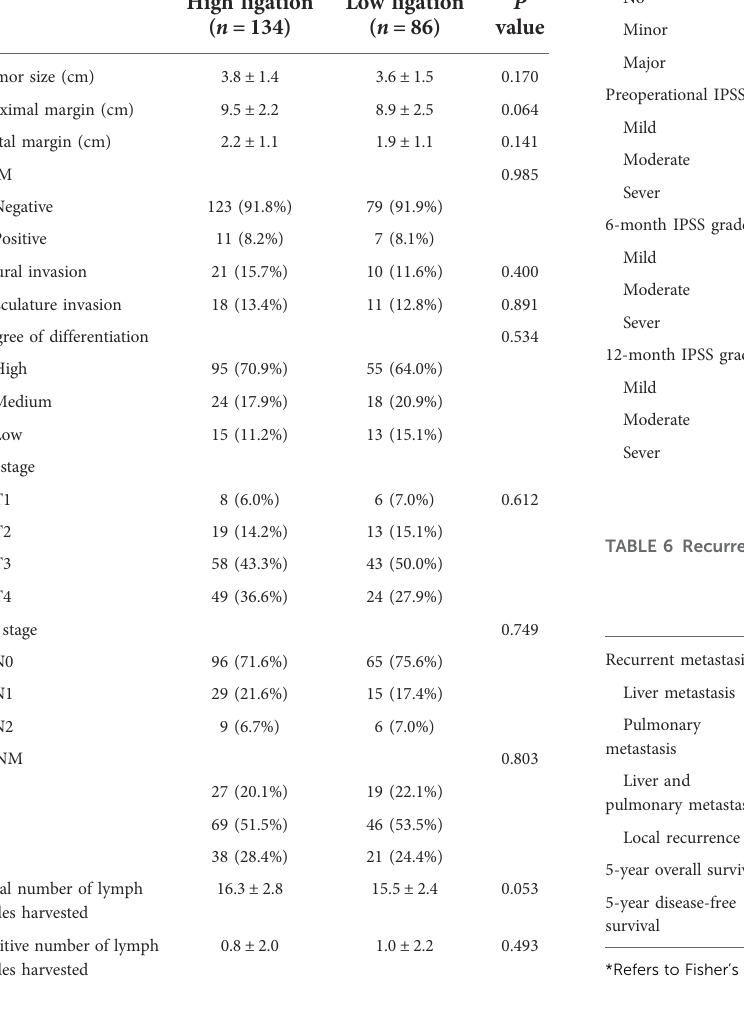
TABLE 4 Pathological